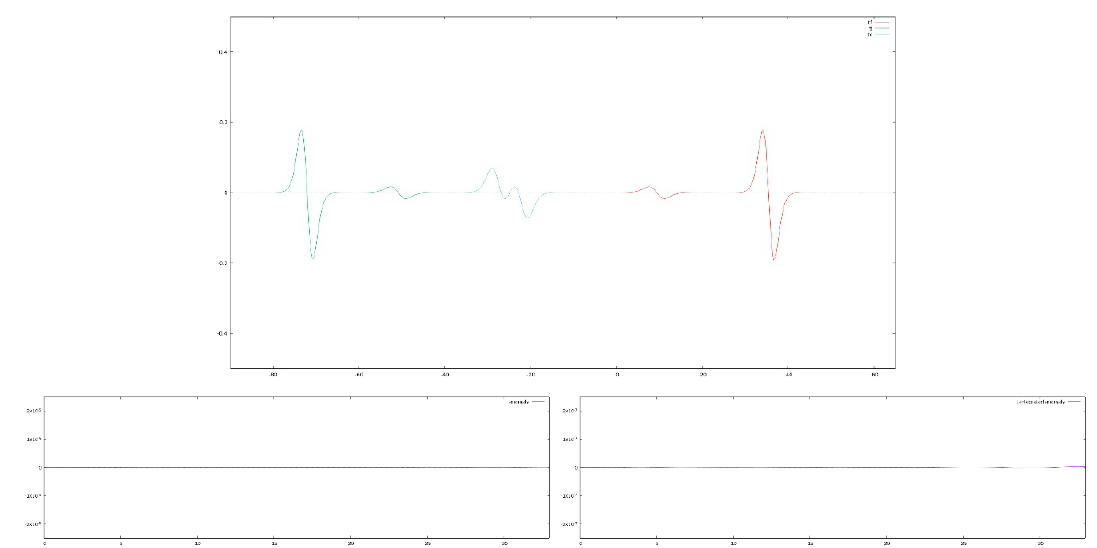
Figure 4 . Top (cid:12)gure shows the anomaly density of e (cid:12) (3) (4.5); i.e. the function ( (cid:0) 6 uu x v t ) plotted in x -coordinate for three successive times, t i = before collision (green), t c = collision (blue) and t f = after collision (red), for the 2-soliton collision of (cid:12)gure 2. Bottom (cid:12)gures show the plots of the anomaly e (cid:12) (3) ( t ) vs. t and the t -integrated anomaly R t e (cid:12) (3) vs. t , respectively. t i